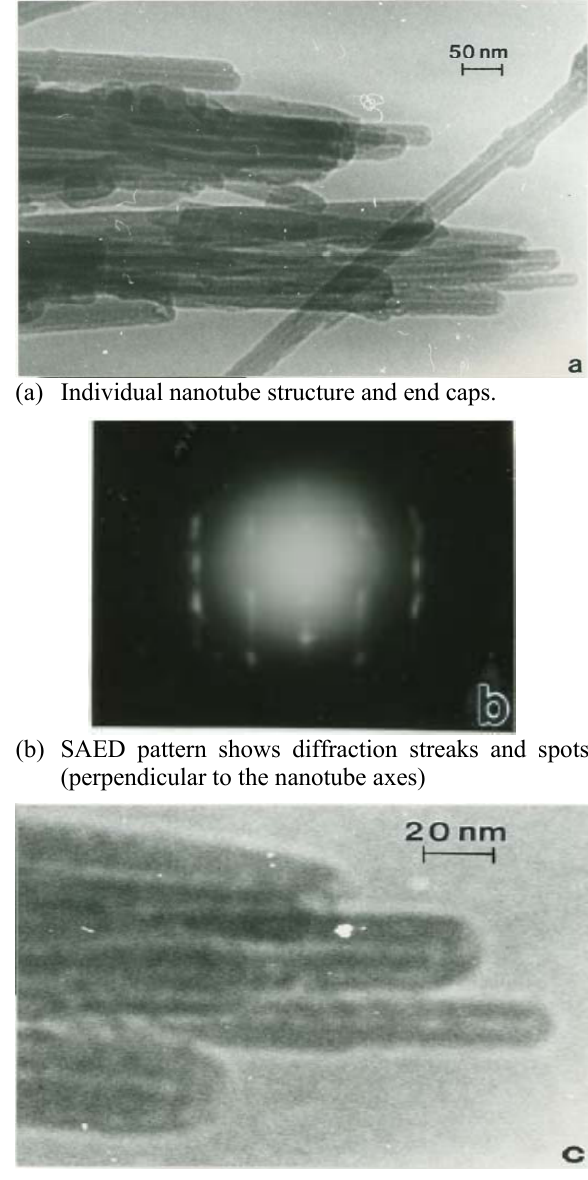
Figure 3: TEM bright-field images of MWCNT aggregates collected form the exhaust streams of kitchen stove-top burners by thermal precipitation.